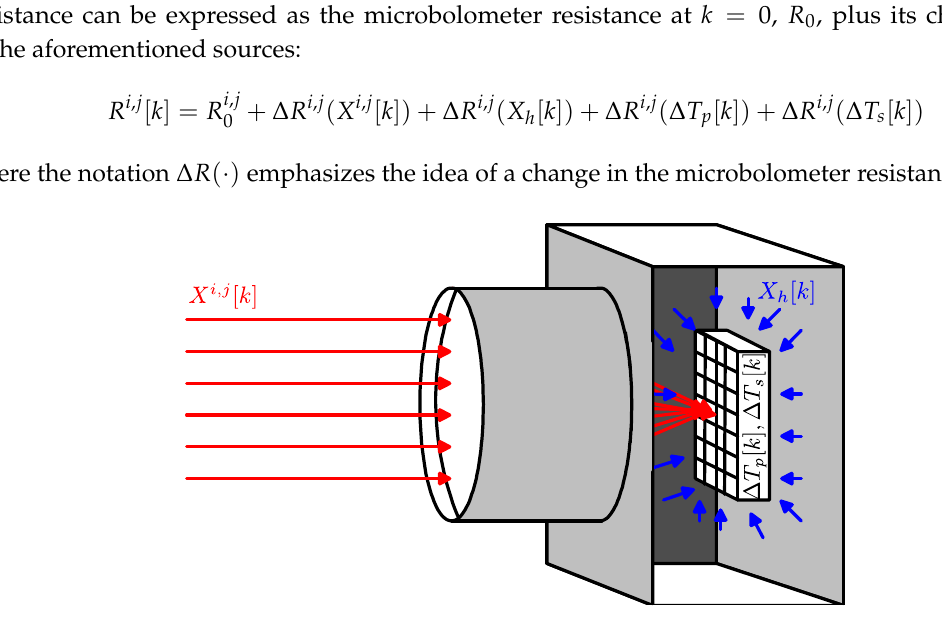
Figure 1. Internal and external sources affecting the microbolometer temperature in an infrared (IR)